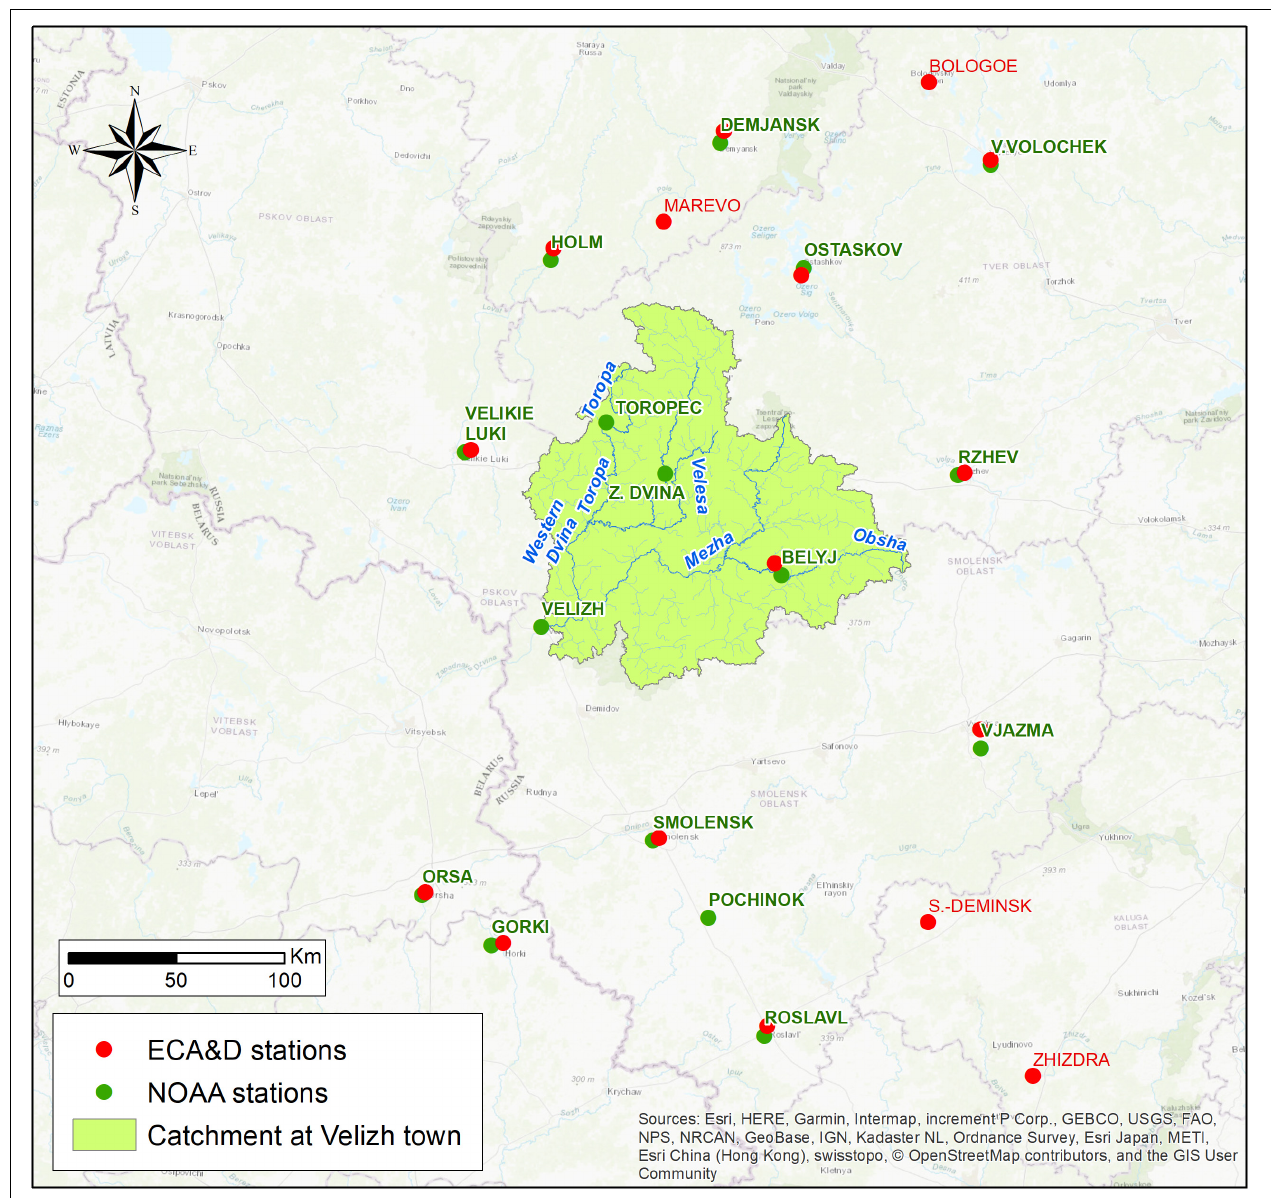
FIGURE 3 | Investigation area (Russian part of Western Dvina catchment). The red color corresponds to the stations from the ECA&D database, green from